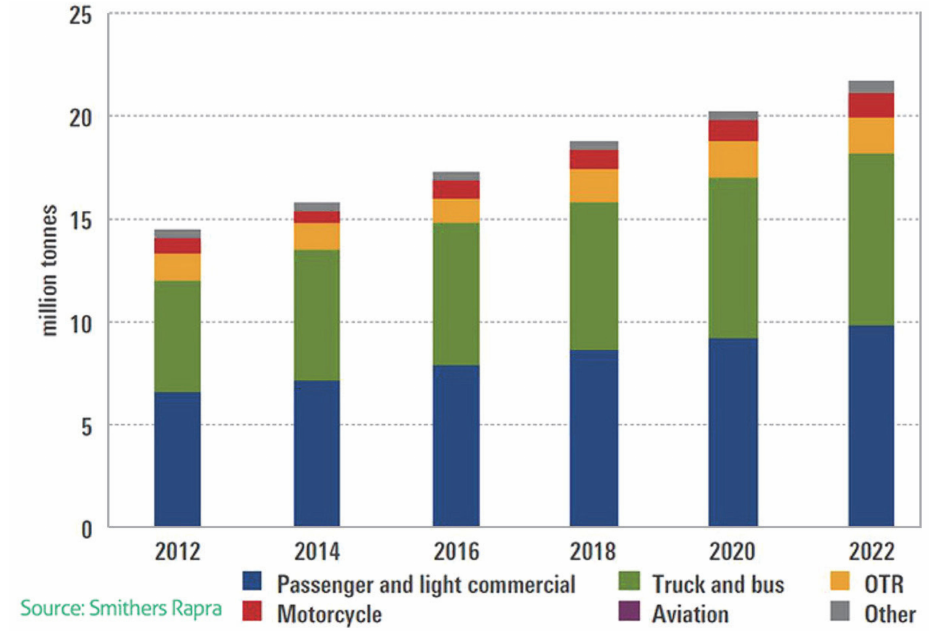
Figure 1. Manufacturing of tires for different applications. Reprinted from ref. [1].